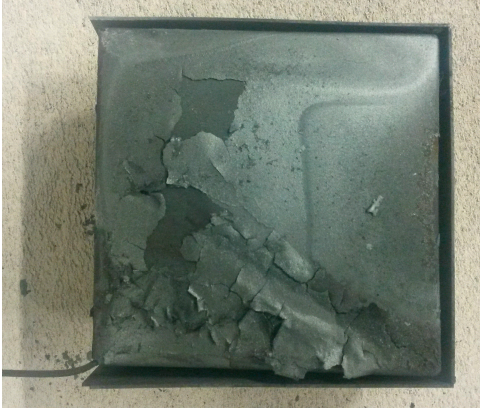
Figure 14. Plate thermometer after Test 2.